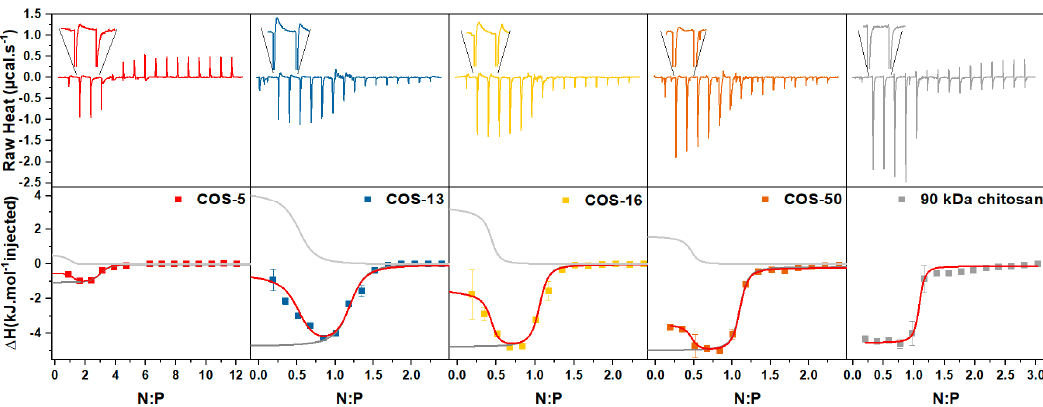
Figure 7. (Upper panel) The heat flow per injection versus time for the isothermal titration of siRNA (0.7 mM) by COS varying in DP (10 mM). The first injection peaks are magnified to illustrate the presence of an endothermic component superimposed on the main exothermic one. (Lower panel) The integrated heats of binding versus the N:P ratio. The continuous red lines represent the overall fit to the experimental data. The dark grey and light grey lines represent the ion-pairing and the aggregation contributions to the overall process, respectively. All titrations were performed at 25 °C in 10 mM acetate buffer at pH 4.5. Table 3. Thermodynamic parameters of the siRNA/COS complexation evaluated by isothermal titration calorimetry (ITC) at T = 298K with a multiple non-interacting sites (MNIS) model by considering two contributions, the ion pairing throughout the titration and the aggregation at initial